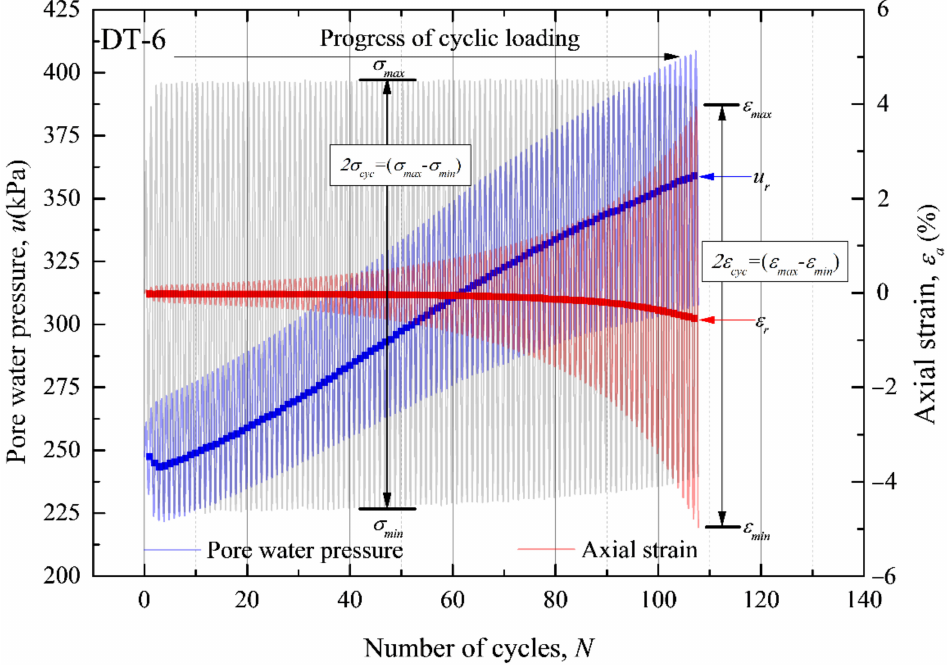
Figure 6. Results of dynamic triaxial test on artificial marine clay